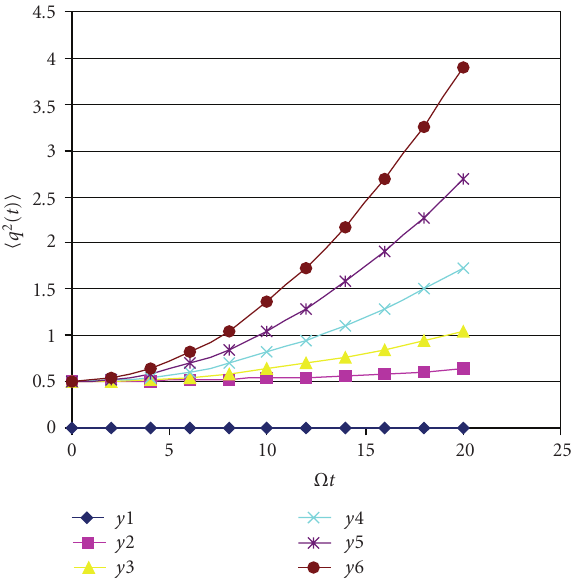
Figure 2: The uncertainties in position for the over-damped oscillator as a function of Ω t is governed by the modified Caldirola- Kanai Hamiltonian with dissipation coe ffi cients γ = 0, 0.2 Ω , 0.4 Ω , 0.6 Ω , 0.8 Ω , and Ω , respectively.